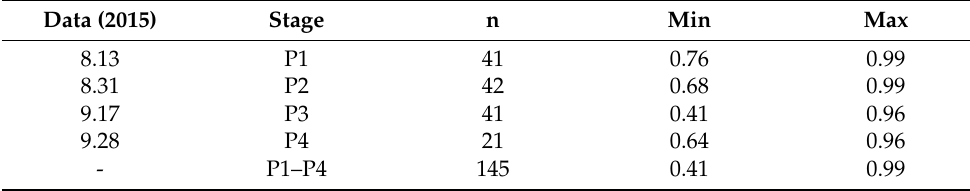
Table 2. Results of soybean FVC field measurements.